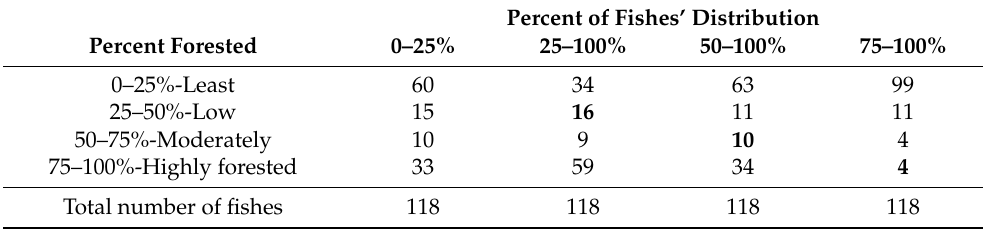
Table 4. Number of imperiled freshwater fishes in each combination of: (a) percent of the distribution of each fish species and; (b) how much of that distribution was classified as forested. Bolded numbers are relationships discussed in the